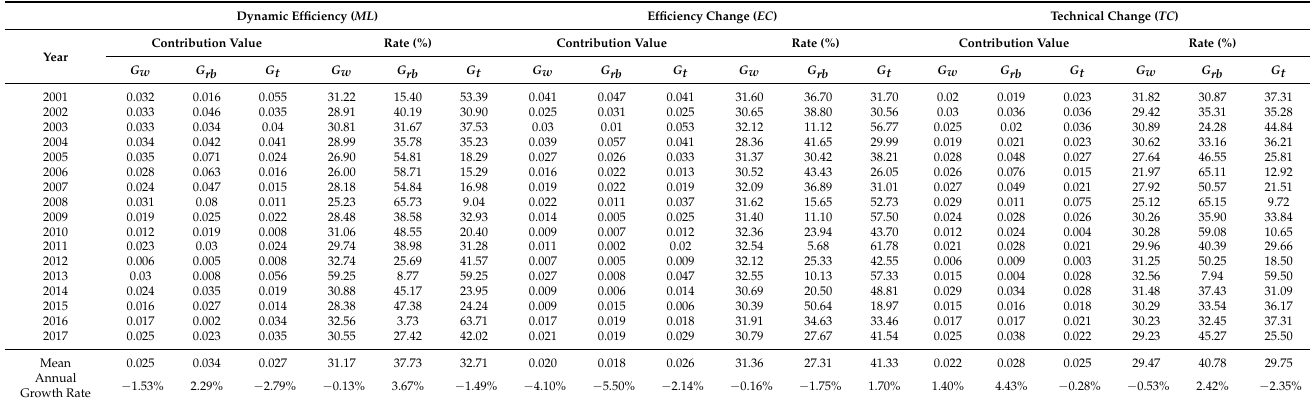
Table 6. The Results of Source Decomposition and Contribution